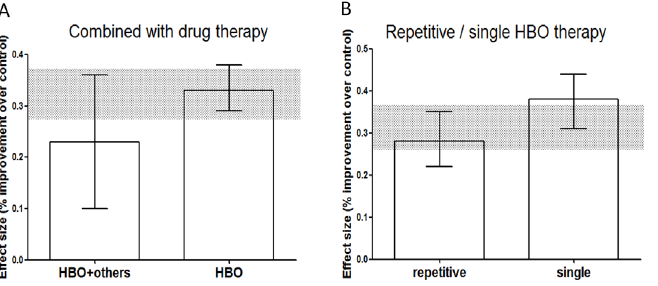
doi:10.1371/journal.pone.0148324.g004